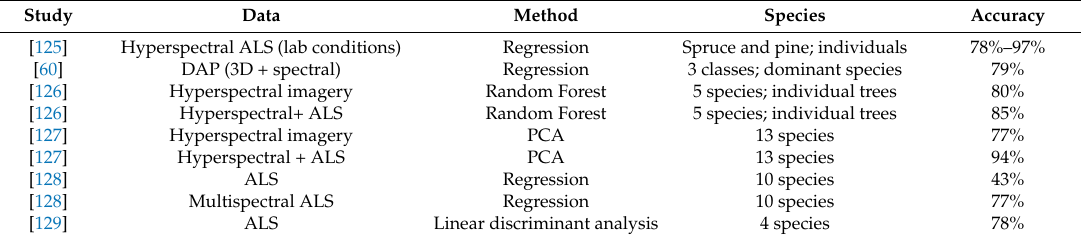
Table 3. Accuracies of methods for species classification using aerial data. ALS: aerial laser scanner; DAP: digital aerial